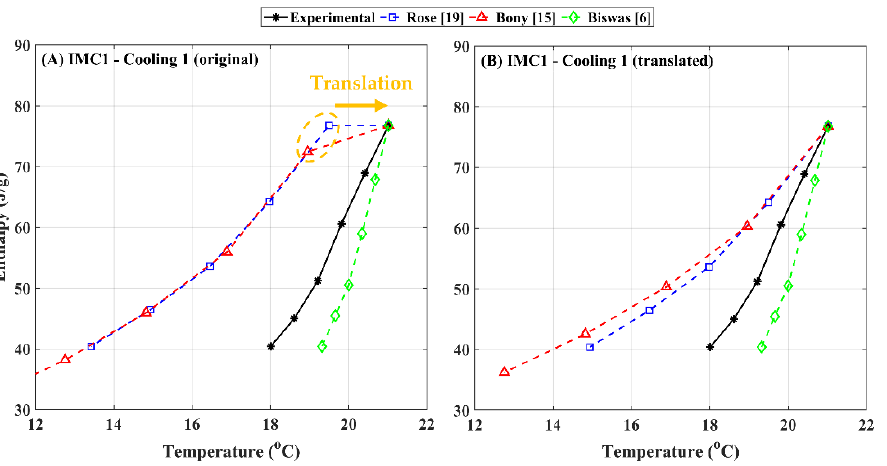
Figure 8. ( A ) Original and ( B ) translated cooling curves during the interrupted heating–cooling– heating test IMC1.